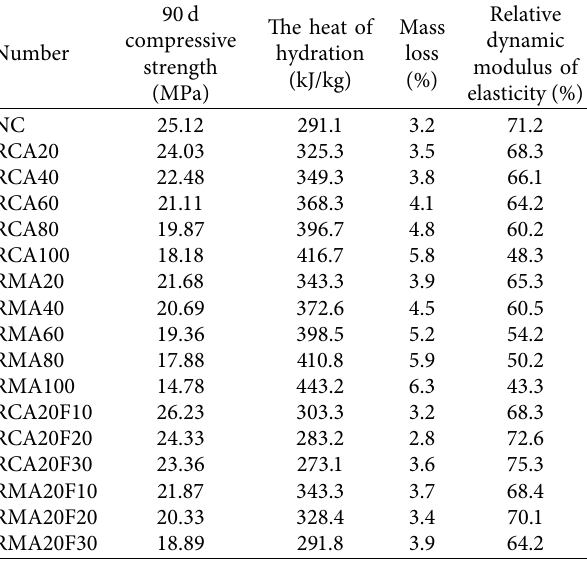
Table 7: Factor values for CCG and